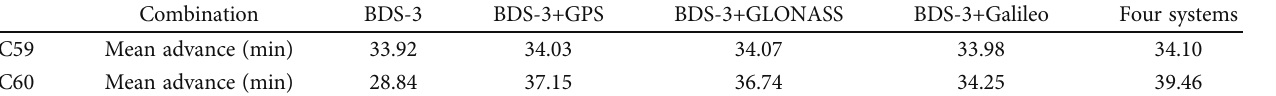
Table 2: Summary of C59 and C60 maneuvering start time detection by di ff erent combinations.